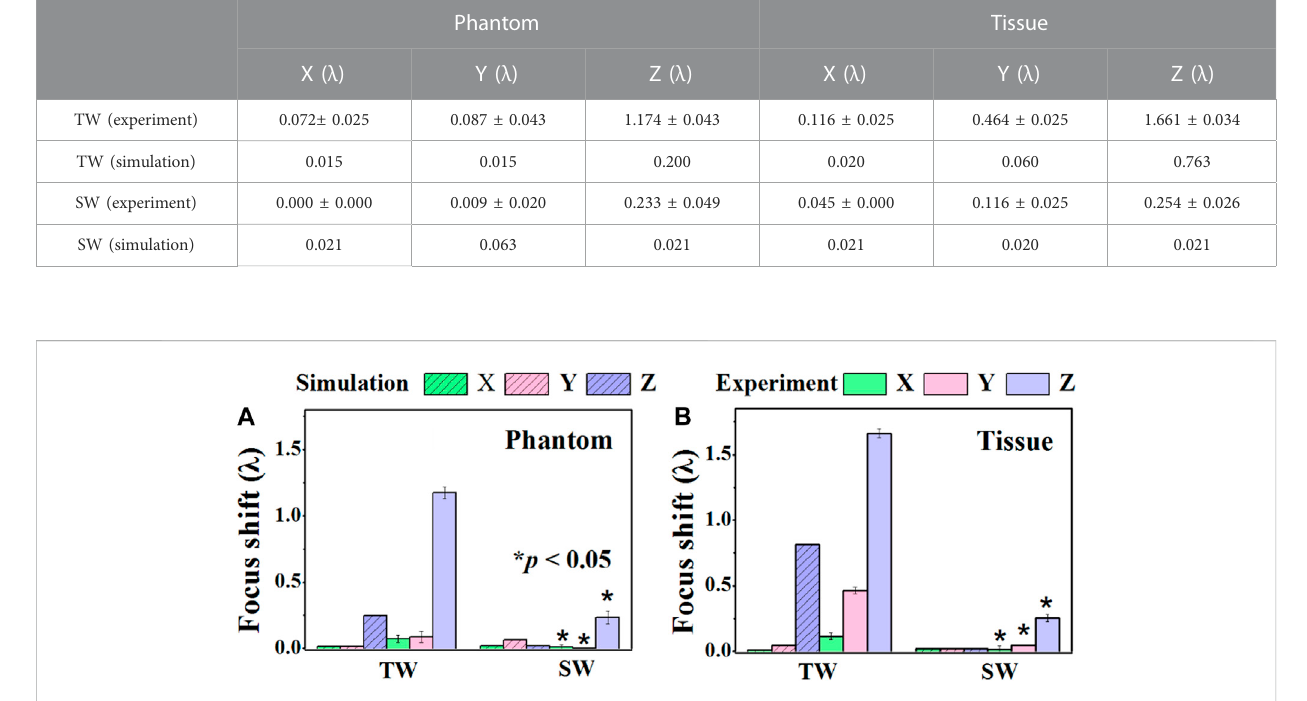
FIGURE 3 Comparison of the focus shifts produced by the traveling wave (TW) by a concave transducer and the standing wave (SW) by a spherical cavity transducer along the X, Y, and Z axes when ultrasound propagates through (A) Phantom and (B) Tissue. *: signi fi cant difference between TW and SW, p <